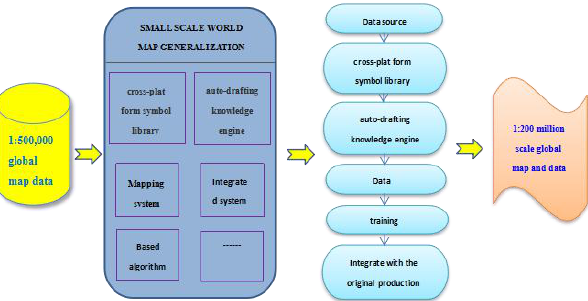
Figure 1. Architecture of the Figure-Number Separation